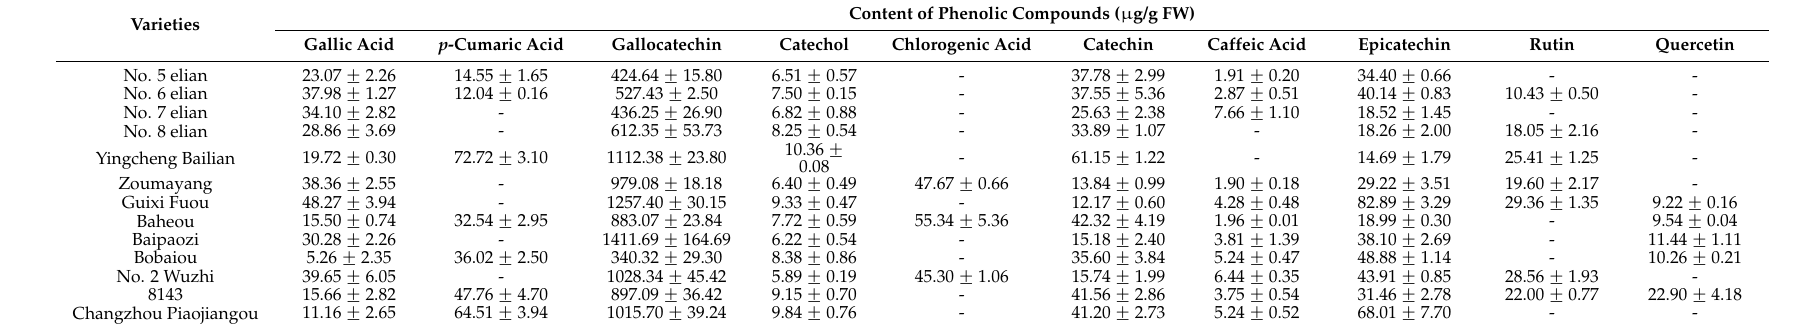
Table 4. Contents of individual phenolic compounds in the nodes of lotus root